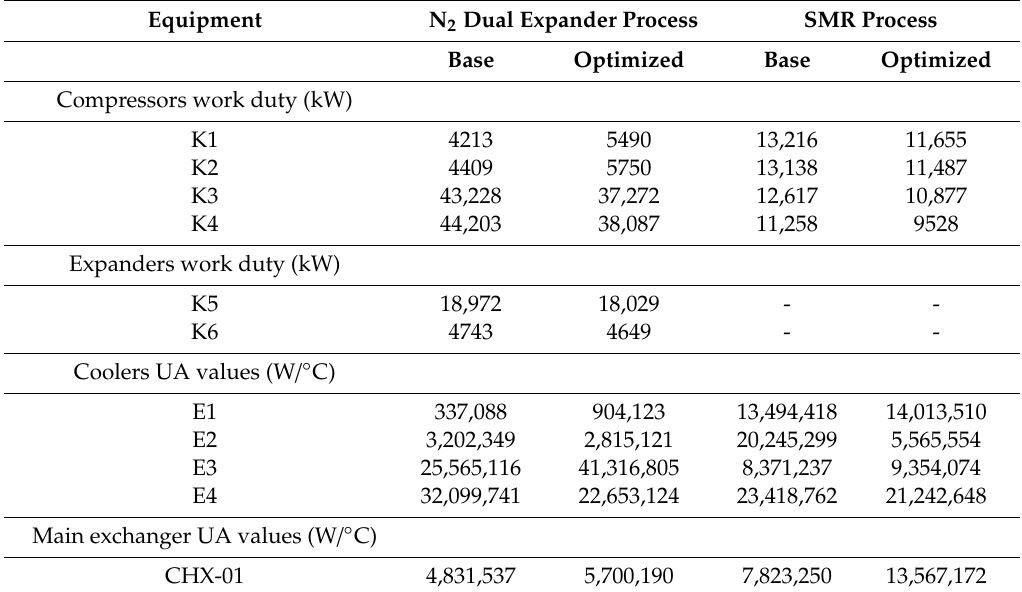
Table 15. Equipment parameters used for economic